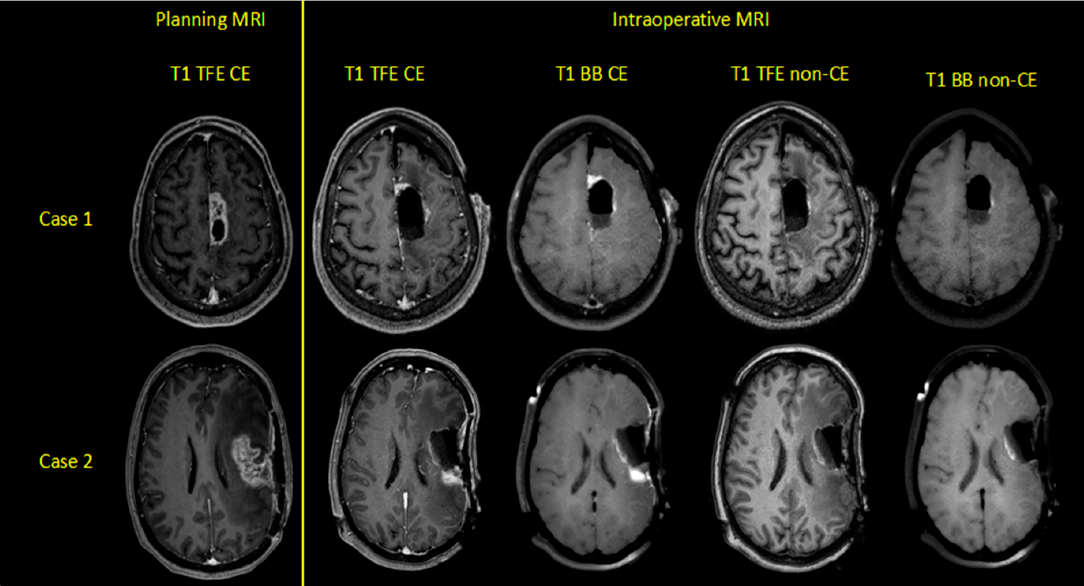
Figure 2. Exemplary cases of two patients harboring left-hemispheric glioblastoma multiforme, depicting contrast-enhanced (CE) and non-CE turbo field-echo (TFE) and Black Blood (BB) sequences for preoperative planning and intraoperative magnetic resonance imaging (iMRI).